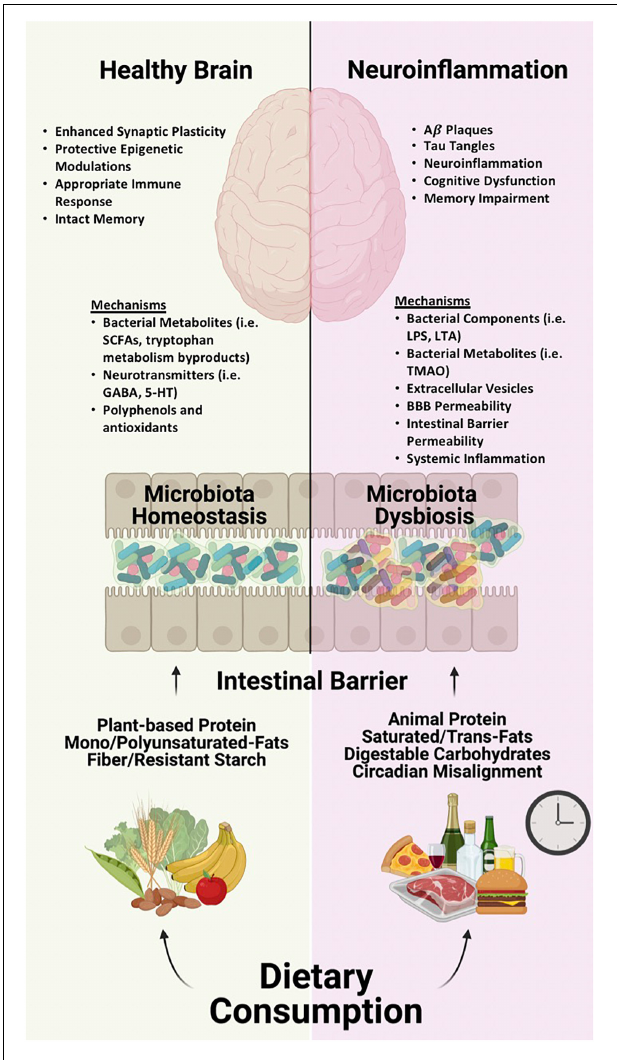
FIGURE 3 | The composition and patterns of dietary intake influence the intestinal microbiome environment, which regulate different mechanisms of communication throughout the microbiota-gut-brain axis, ultimately impacting brain health. Healthy Brain: A diet rich in plant-based protein, mono/polyunsaturated fats, and fiber/resistant starches induce an anti-inflammatory microbiome, which elicits protective mechanisms